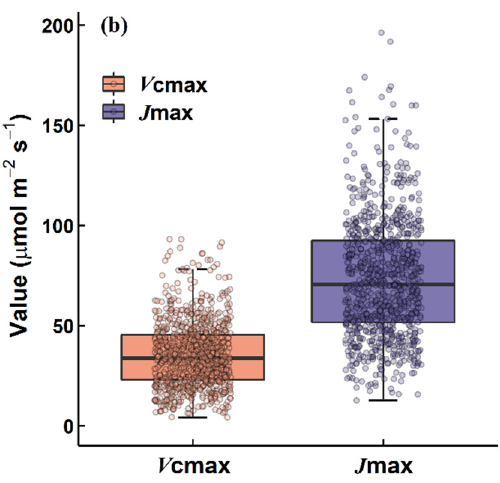
Figure 1. The spectra data with 2051 features (400–2450 nm) ( a ) and the corresponding photosynthetic traits of maximum carboxylation rate ( V cmax) and maximum electron transport ( J max) ( b ), in the Naeba dataset.